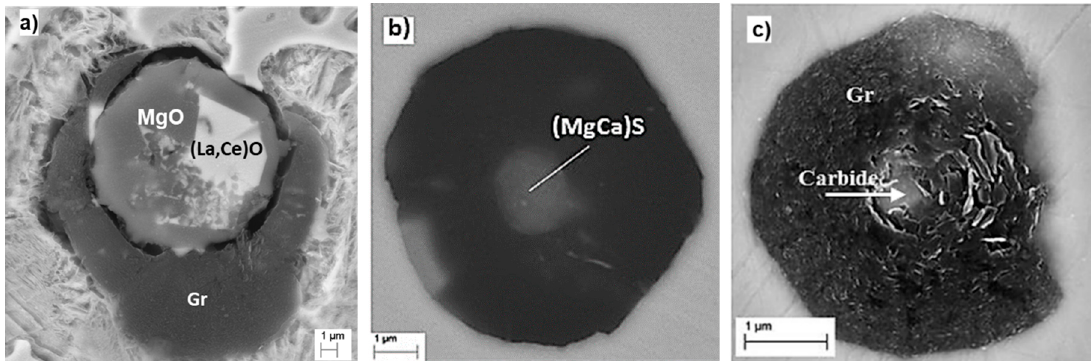
Figure 16. Examples of spheroidal graphite (SG) nucleation: ( a ) Two-stage nucleation on oxides; ( b ) one stage nucleation on sulfide; ( c ) one-stage nucleation on TiC; reproduced after [87] with permission from Springer.